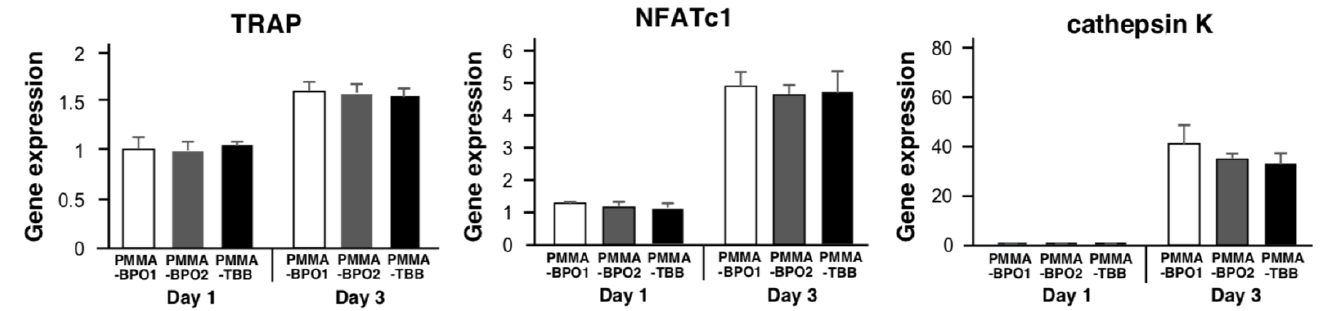
Figure 6. Evaluation of osteoclast activity stimulated by three different bone cement extracts. Relative gene expression levels of osteoclast TRAP, NFATc1, and cathepsin K after 1 and 3 days of exposure to bone cement extracts. Data shown are mean ± SD ( n = 3).